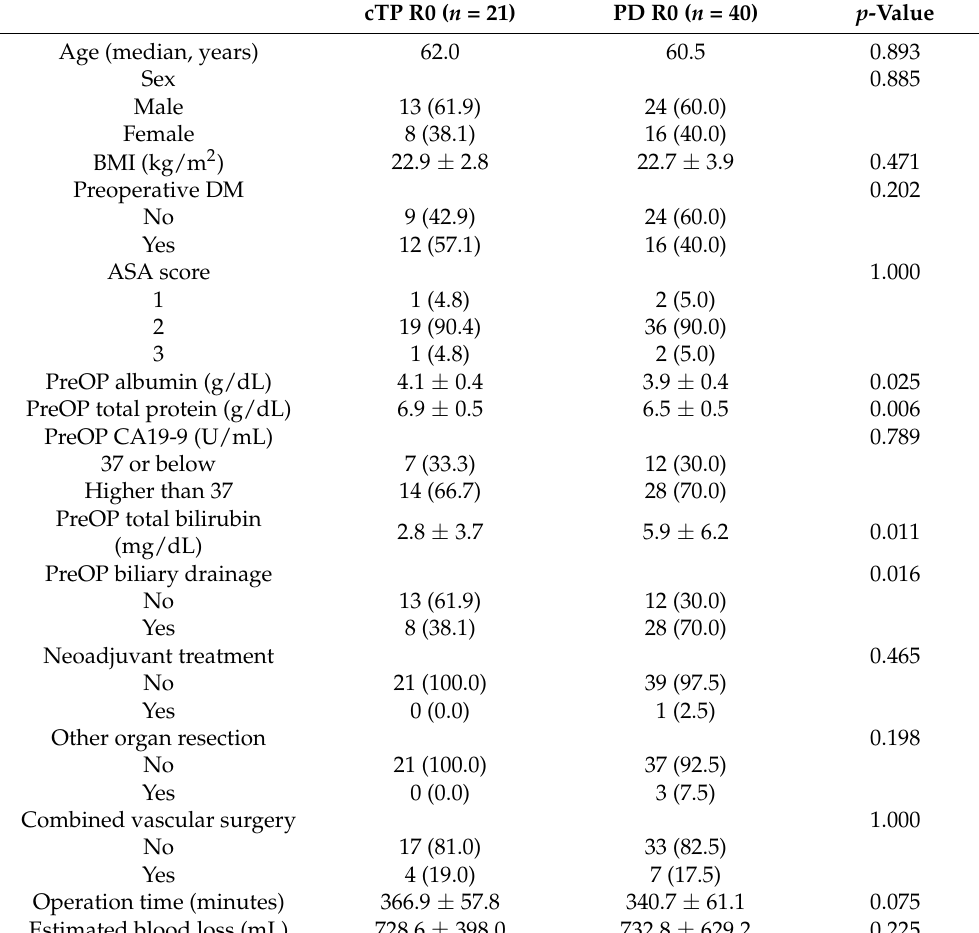
Table 2. Comparison of clinical and operative characteristics between cTP R0 group and PD R0 group extracted by PSM (number (percent) and mean ± standard